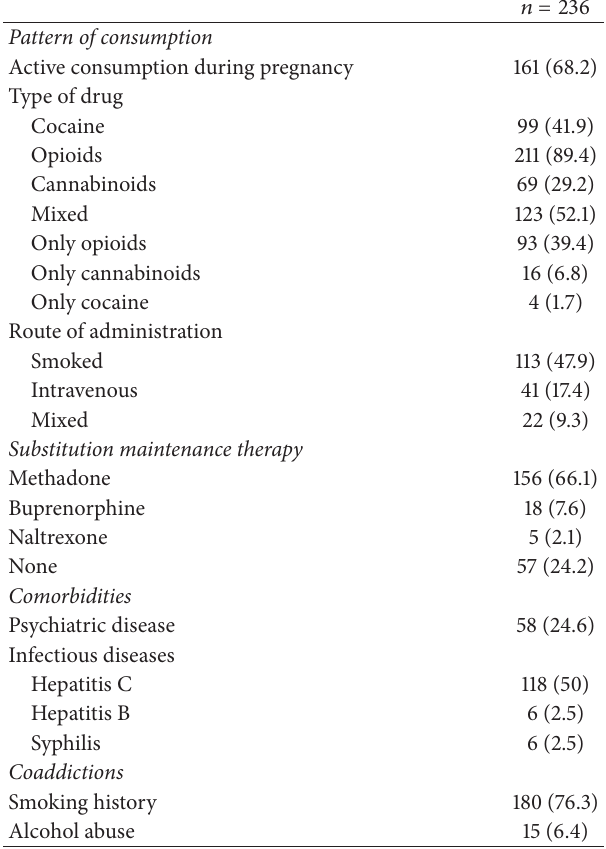
Table 3: Drug dependent group